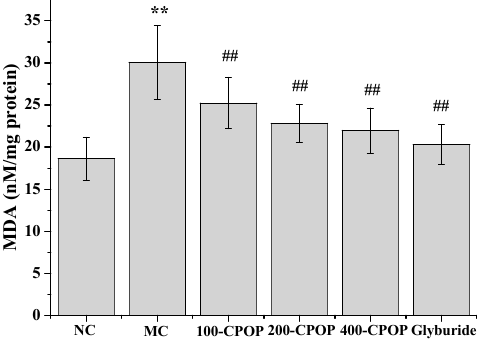
Figure 8. Effect of CPOP on methane dicarboxylic aldehyde (MDA) contents in liver tissues of STZ-induced diabetic rats. ** p < 0.01 vs. NC group ( N = 8); ## p < 0.01 vs. MC group ( N = 8). NC is the normal control group; MC is the model control group; 100-CPOP is the 100 mg/kg per body weight CPOP group; 200-CPOP is the 200 mg/kg per body weight CPOP group; 400-CPOP is the 400 mg/kg per body weight CPOP group.